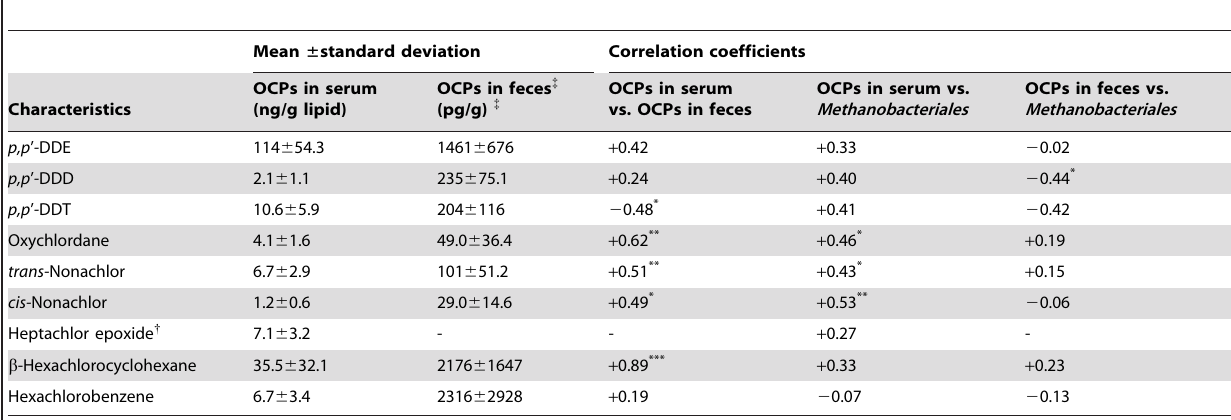
Table 3. Correlation coefficients among serum concentrations of organochlorine pesticides (OCPs), stool concentrations of OCPs, and levels of Methanobacteriales (n=16 {{ ).